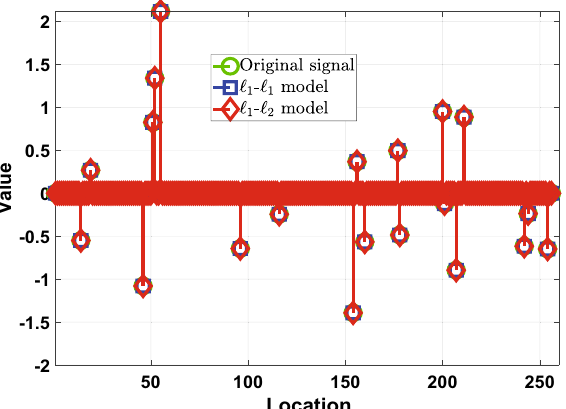
Fig. 1 Recovery performance of the models (1.3) and (1.4) on a given sparse signal with side information